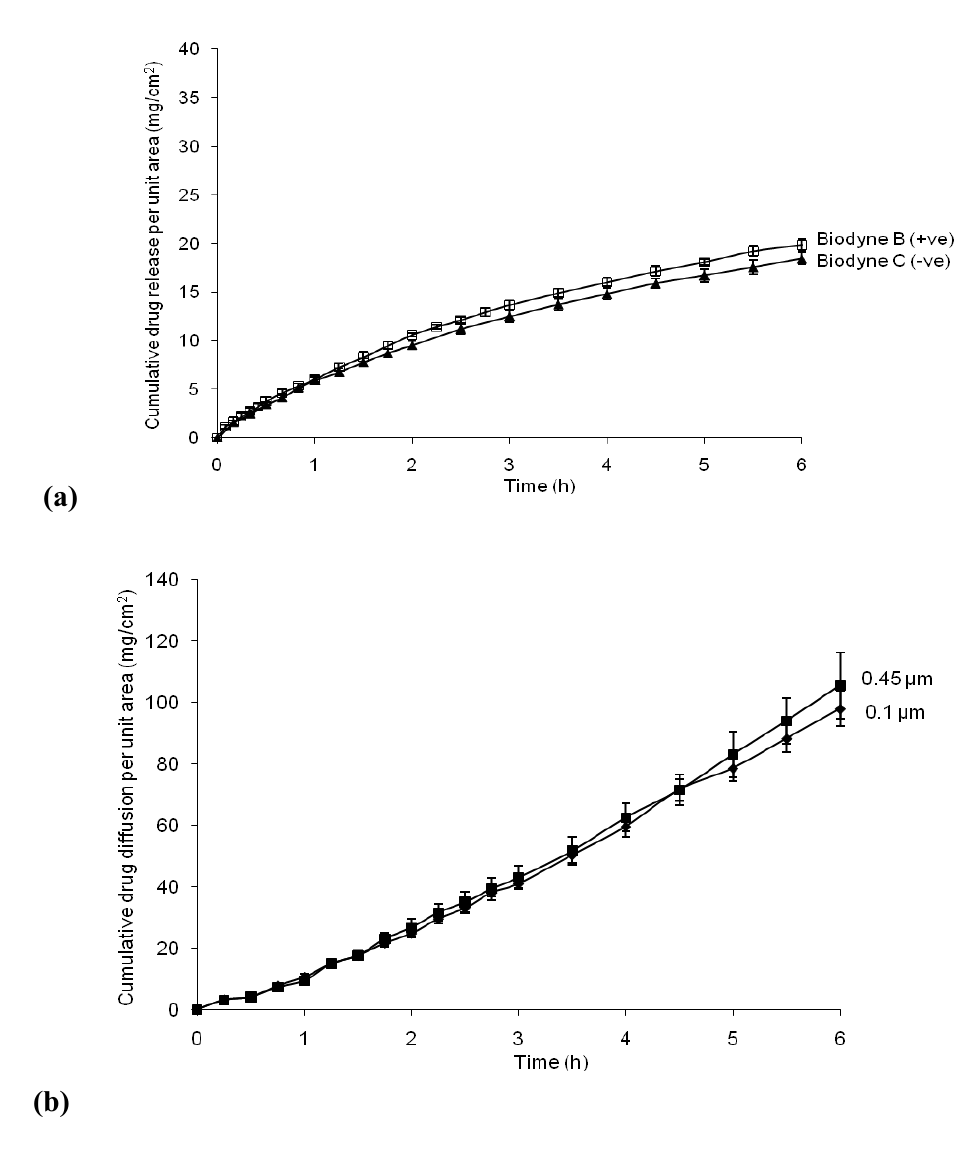
Figure 3. (a) Ibuprofen drug diffusion through cellulose nitrate membrane of different pore sizes (0.45 µm and 0.1 µm) over 6 h; (b) ibuprofen drug diffusion through membrane of different membrane surface groups ( Biodyne B +ve and C -ve) over 6